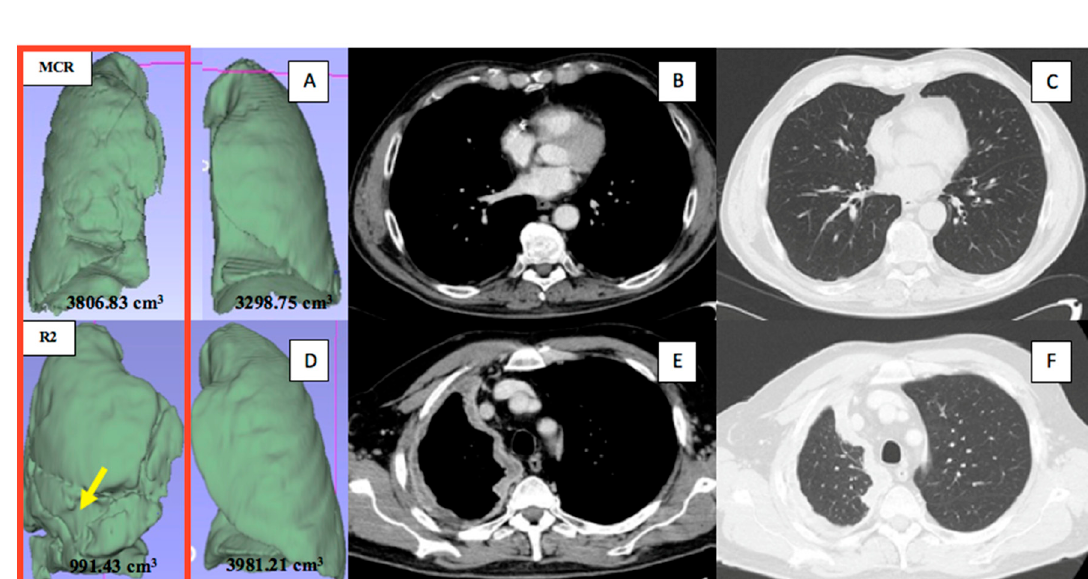
Figure 2. Comparison of between resectable (MCR) and unresectable (R2) cohorts in TLC% ( A ), ipsilateral lung volume ( B ), disease burden ( D ), and difference in contralateral and ipsilateral lung volume ( E ). Correlation between the increase of disease burden with both the decrease of the ipsilateral pathological lung volume ( C ) and the increase of the difference between the contralateral and the ipsilateral pathological lung ( F ). TLC: total lung capacity.